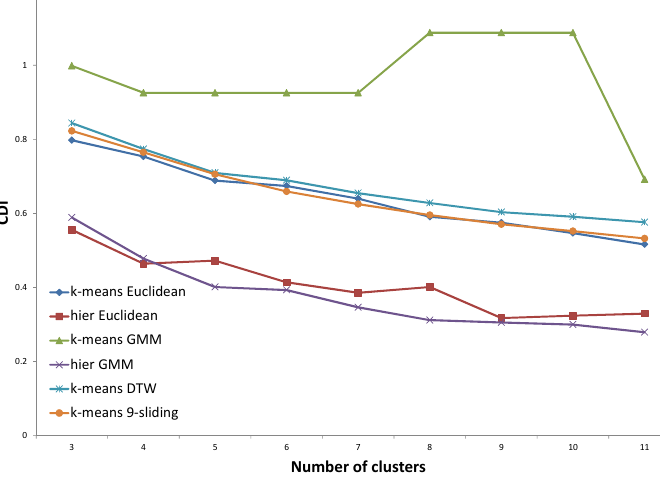
Figure 5. CDI (Clustering Dispersion Index) result for the southern part of Gyeonggi